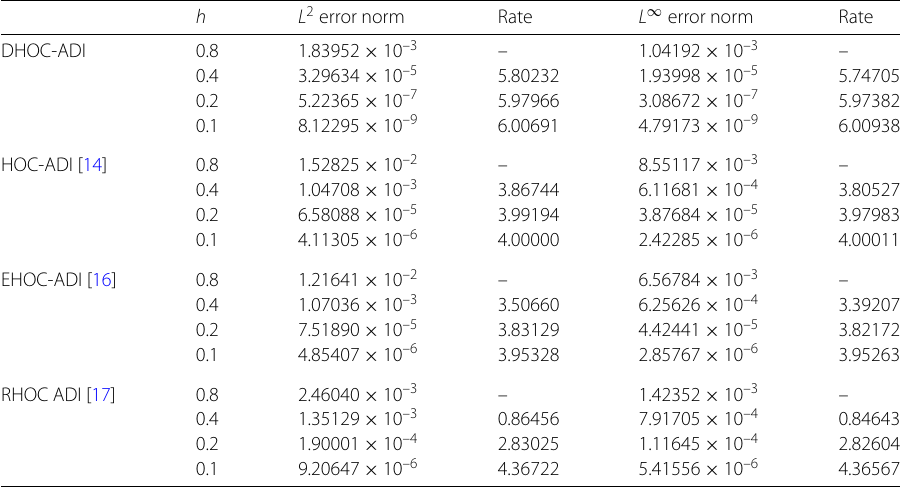
Table 1 The error norms of numerical solutions and the rate of convergence in space where τ = 0.0001